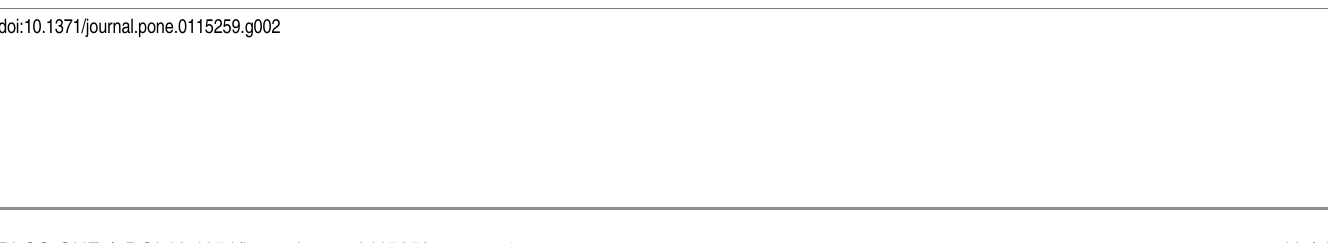
PLOS ONE | DOI:10.1371/journal.pone.0115259 December 15,